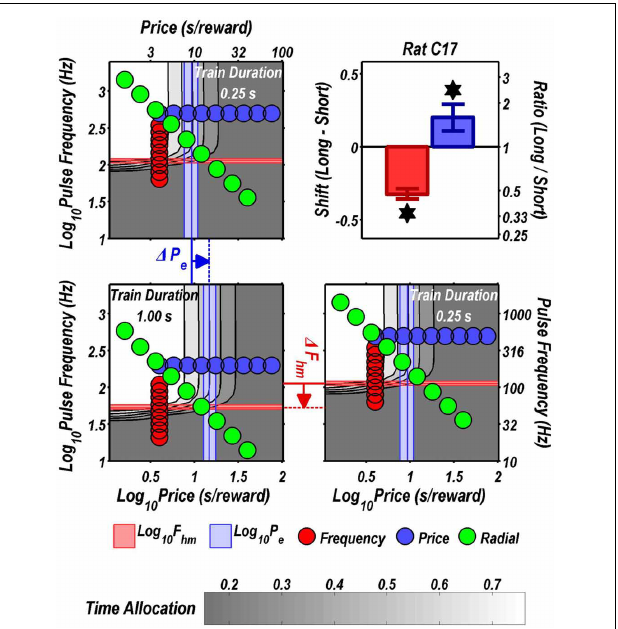
FIGURE 3 | Shifts of the reward mountain. The contour graph for the long-duration (1s) train is shown in the lower left. For comparison the contour graph for the short-duration (0.25s) train is shown twice, in the upper left and lower right. The P e parameter determines the location along the price axis, whereas the F hm parameter determines the location of the mountain along the pulse-frequency axis. The vertical blue line represents the estimate of P e , and the surrounding band represents the corresponding 95% confidence interval. The horizontal red line represents the estimate of F hm , and the surrounding band represents the corresponding 95% confidence interval. The bar graph shows the mean shifts in the location parameters due to the increase in train duration from 0.25 to 1s along with the associated 95% confidence intervals. ∗ Indicates that the 95% confidence interval does not include